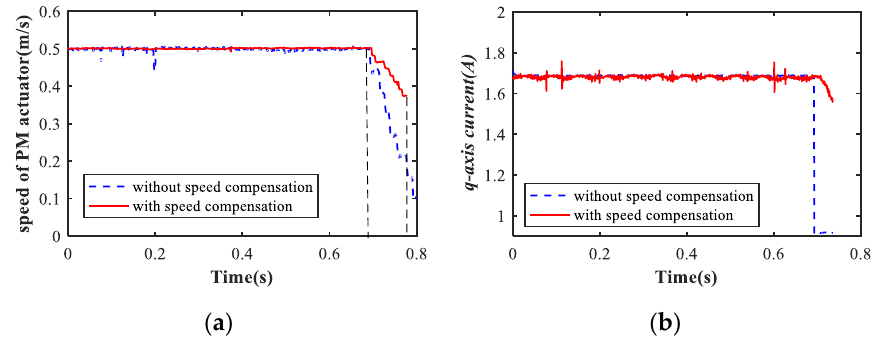
Figure 12. ( a ) Speed curves of segmented PMLSM with different models during switch process; ( b ) q -axis current of segmented PMLSM with different models during switch process.